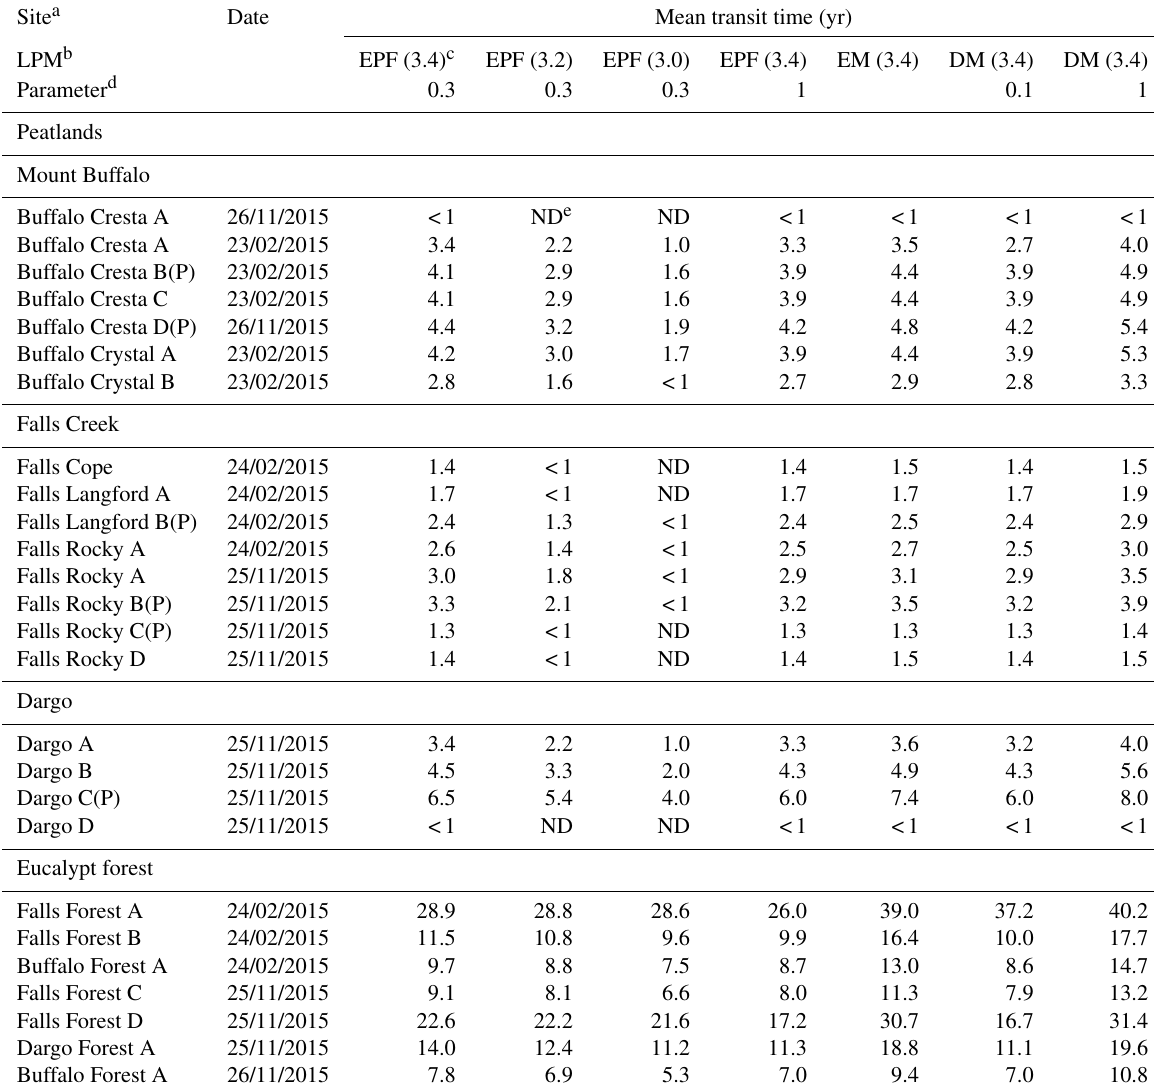
a Sites in Fig. S1 and S1. b Lumped parameter model (DM indicates dispersion model; EM indicates exponential flow model; EPF indicates exponential-piston flow model). c Assumed 3 H activity of modern recharge in brackets. d EPM or D P parameter. e Not determined as 3 H activity higher than assumed value of